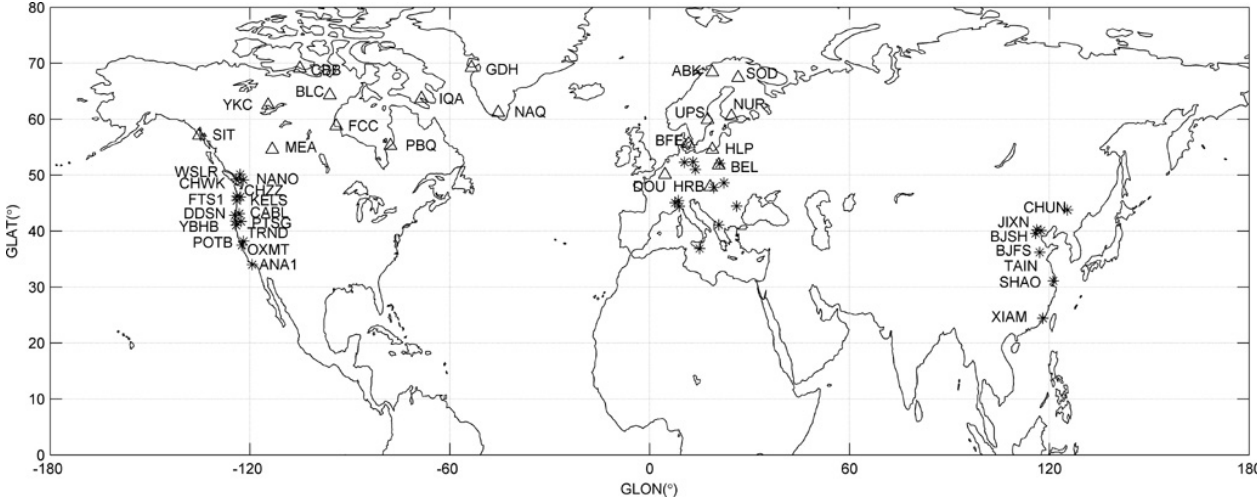
Fig. 1. Geodetic locations of geomagnetic observatories (triangle) and locations of the GPS receivers (asterisk) used in this paper. The code name for each geomagnetic observatory was marked on the map, and the names of some GPS receivers were also marked on the